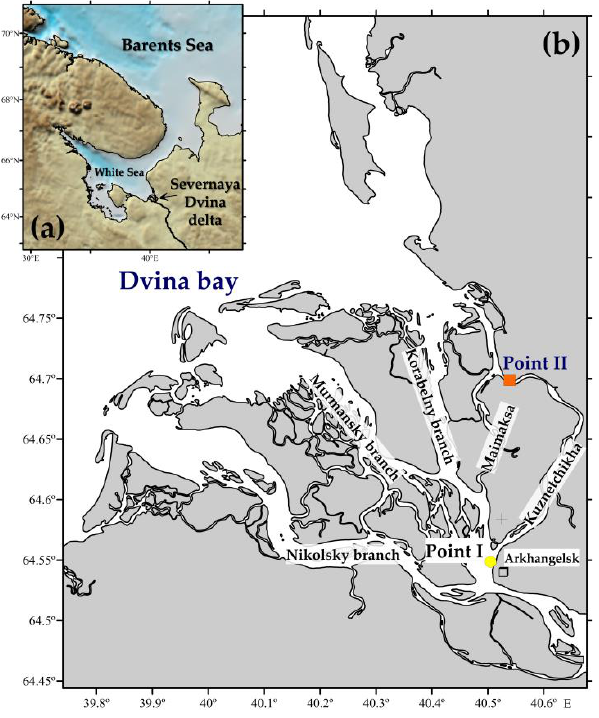
Figure 1. The White Sea position ( a ) and location of two sampling points ( b ).